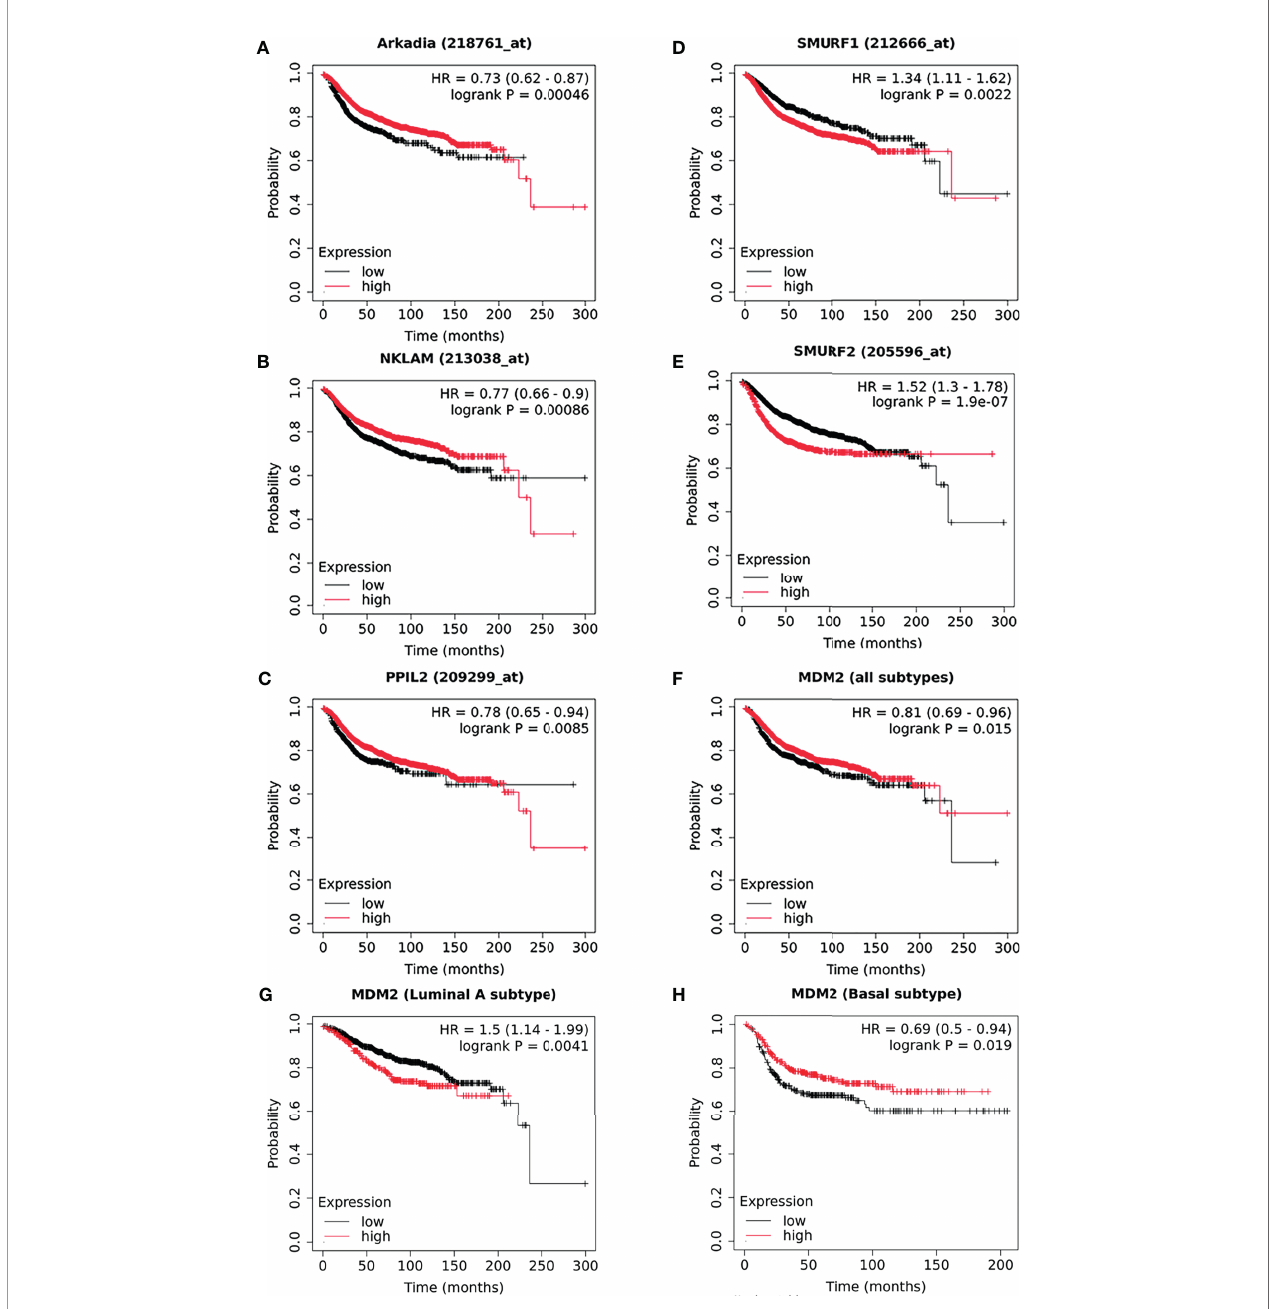
FIGURE 4 | The survival curves comparing patients with high and low expressions of E3s in breast cancer patients. As a supplement to the literatures, the survival analysis of Arkadia (A) , NKLAM (B) , PPIL2 (C) , Smurf1 (D) , and Smurf2 (E) , which were illustrated as a Kaplan – Meier plot. Distant metastasis – free survival curves for high (red) and low (black) expression groups dichotomized at the optimal cut-point. The survival analysis of MDM2 in breast cancer was shown as all types (F) , luminal A (G) subtype, and basal subtype (H) , respectively. Logrank P-value and the hazard ratio with 95% con fi dence intervals was calculated. The threshold was adjusted to logrank P ‐ values at <